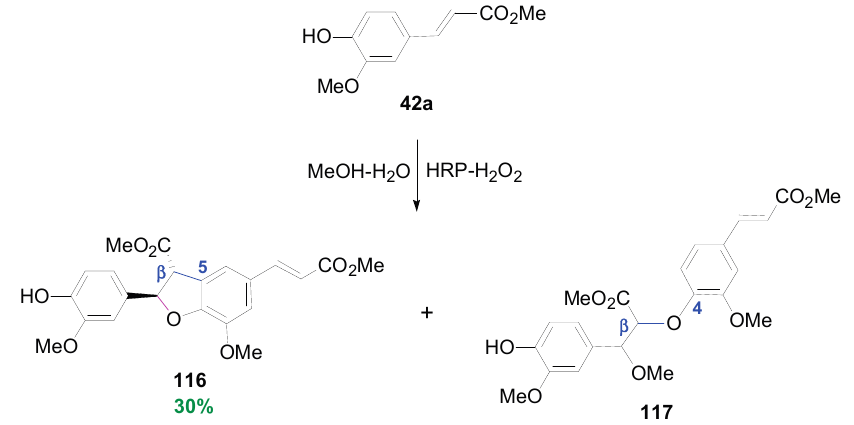
Scheme 49. Synthesis of neolignan 116 through oxidative dimerization of Me-Fer using HRP-H 2 O 2 as oxidant